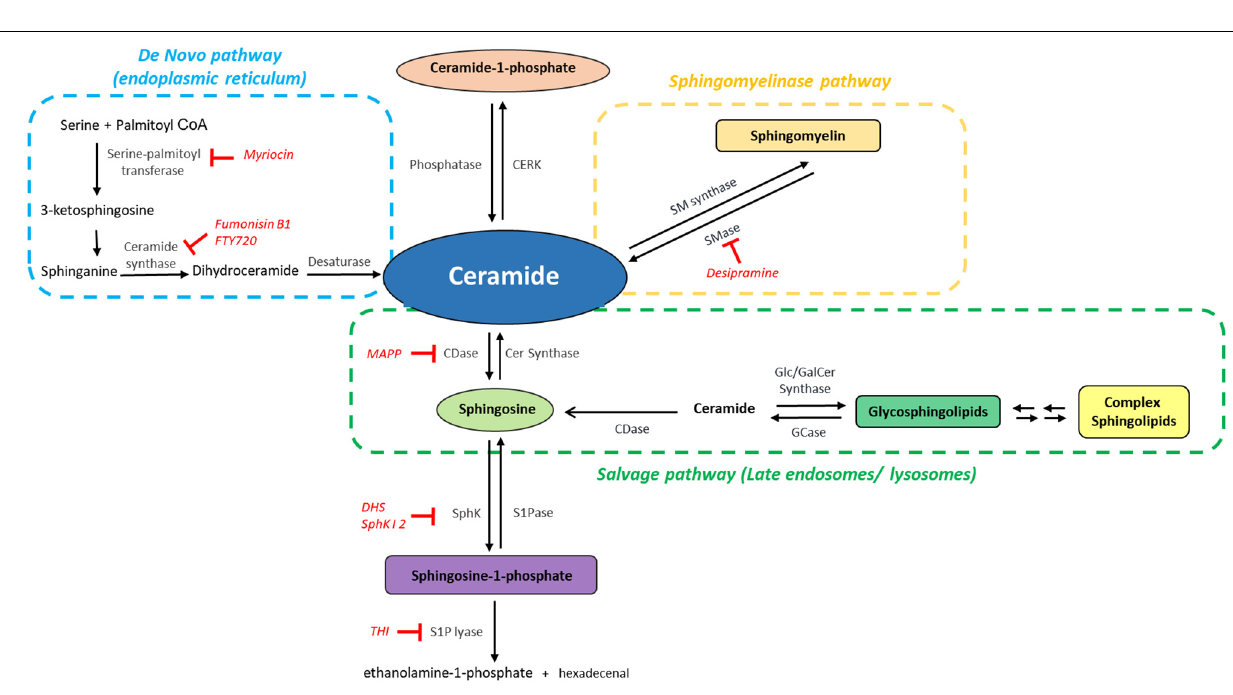
FIGURE 2 | The sphingolipid network: metabolic interconnection between bioactive sphingolipids. Ceramide, the central hub of sphingolipid metabolism, is synthesized by the de novo pathway (light blue), from serine and palmitoyl CoA, by the sphingomyelinase pathway, i.e., through hydrolysis of sphingomyelin mediated by sphingomyelinases (SMase) (orange) or by the salvage pathway (green). Ceramide can then be phosphorylated to generate Ceramide-1-phosphate and/or deacylated to form sphingosine, which is then phosphorylated to generate sphingosine-1-phosphate (S1P). The catabolism of S1P mediated by S1P lyase provides the only exit route from the sphingolipid network. CDase, ceramidase; CERK, ceramide kinase; GCase, glucosylceramidase; SMase, sphingomyelinase; SM synthase, sphingomyelin synthase; SphK, sphingosine kinase; SPPase, sphingosine phosphate phosphatase. The inhibitors mentioned in this Review are indicated in